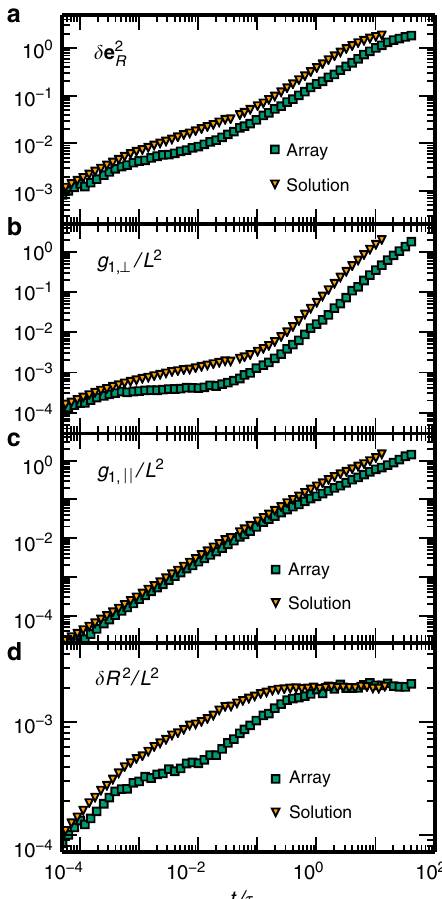
Fig. 6 Comparison between dynamics in a fi xed array and an entangled solution. Key quantities characterising the dynamics of a tracer polymer in a fi xed array (green squares) or an entangled solution (yellow triangles) for a system with ξ / L = 0.086 and ‘ p = L ¼ 3. To emulate a fi xed array, we used an equilibrated con fi guration of the entangled solution and froze the con fi guration of all but one tracer polymer, which is reminiscent of the experimental situation in ref. 15 . a In a fi xed array, relaxation of a tracer (cid:3) (cid:4) polymer ’ s orientation δ e 2 is much slower and follows the scaling R predictions of Odijk and Doi. b Moreover, the MSD of the polymer ’ s fl uctuations transverse to the end-to-end vector ( g 1, ⊥ ) exhibits a clearly visible plateau in a fi xed array, but continues to relax in an entangled solution. c At asymptotically large times, the transverse MSD and likewise (cid:3) (cid:4) the longitudinal MSD g 1 ; jj is slowed down in a fi xed array. d Finally, the relaxation of internal bending modes ( δ R 2 ) shows a qualitatively different behaviour: While there is an intermediate regime where δ R 2 ( t ) appears to saturate, which re fl ects caging in a tube, this is not the case for an entangled solution. There, internal modes continuously relax, indicating ongoing tube reorganisation with concomitant relaxation of